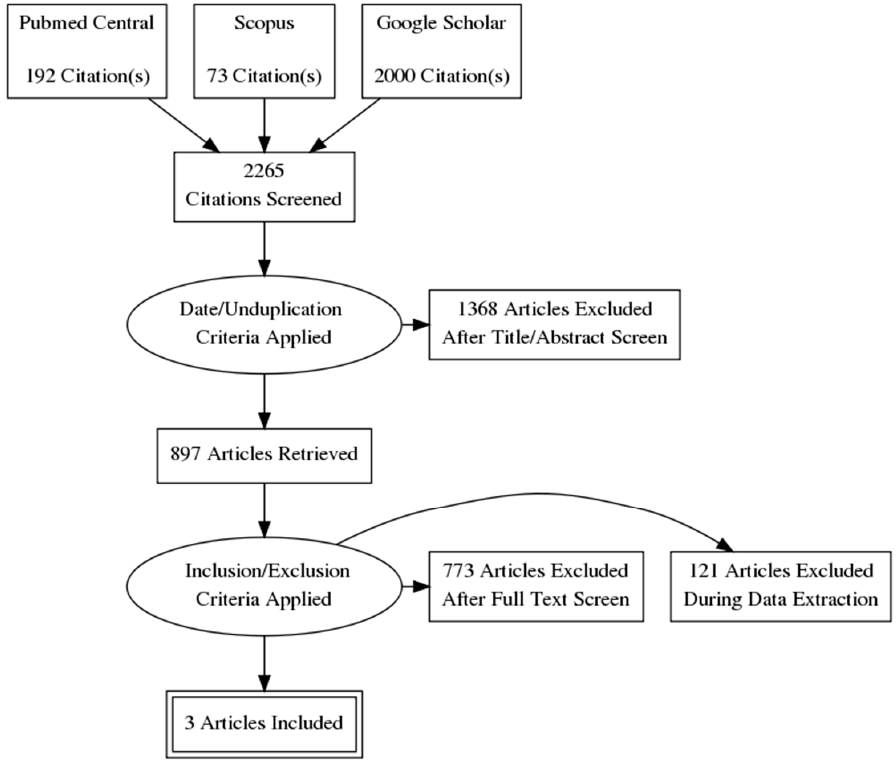
Figure 2. Flowchart of study identification and selection process. Table 1. Main characteristics of the included studies.